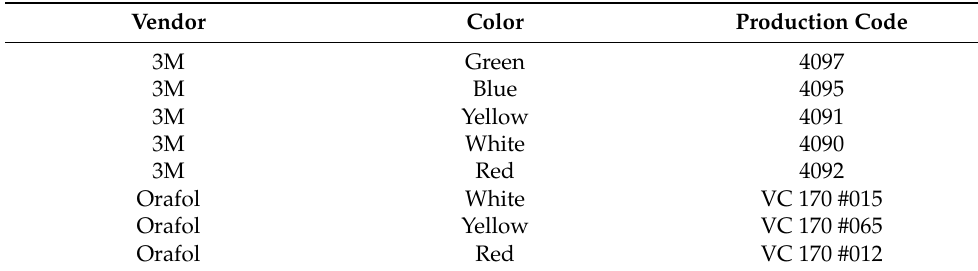
Table 1. Summary of the utilized retroreflective foils.